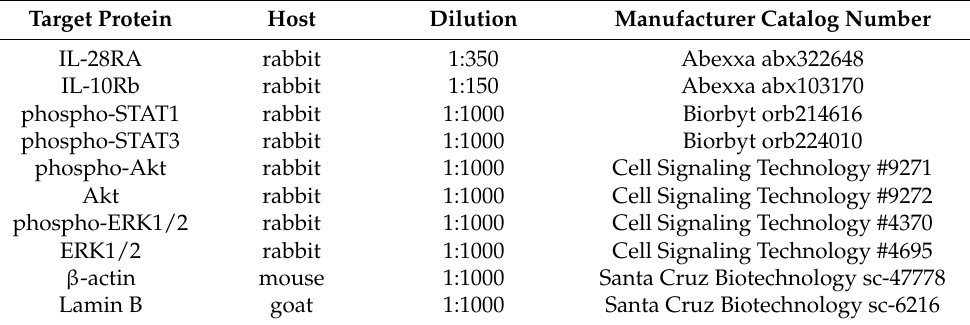
Table 2. Primary antibodies used for Western blot